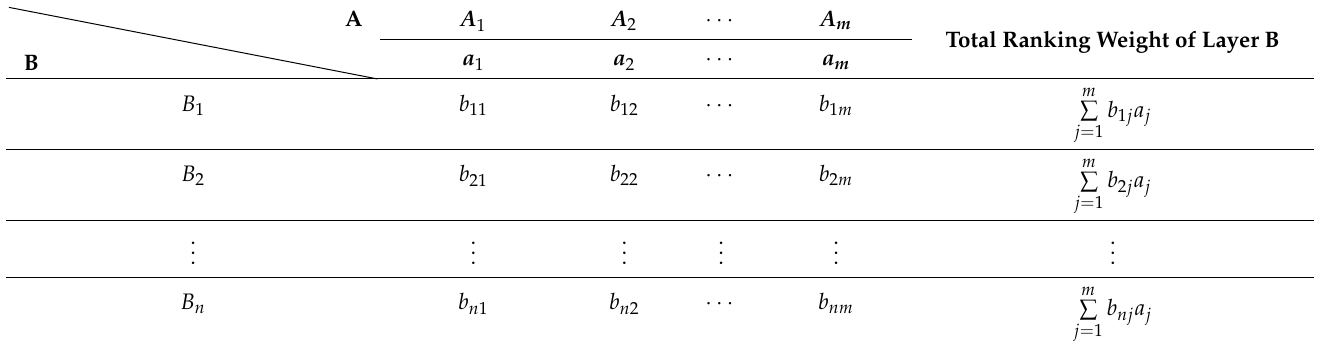
Table 1. Total ranking weight of layer